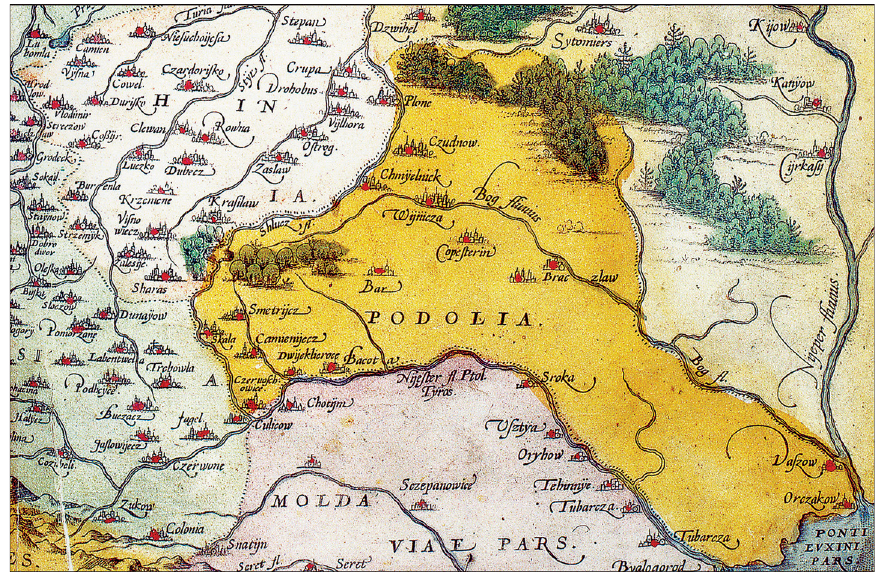
Fig. 1. Part of the map of Poland by W. Grodecki